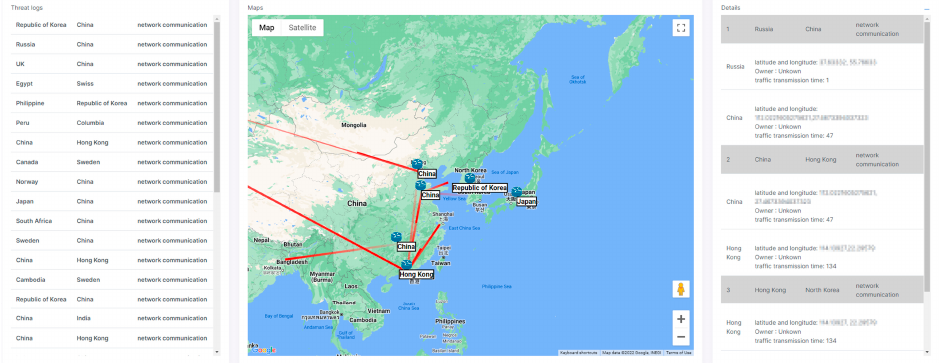
Figure 7. Visualization ① : Visualization of Internet Network Activity in the Area of Interest. Visualization ② uses the same map service API as Google Maps to visualize the satellite view-based map, as shown in Figure 8. On top of that, geographic information such as GeoJSON, other data, internal network information, and information such as the location/facility/building are mixed and visualized. The left interface shows the legend of the icons, and the central interface shows the satellite view-based map.